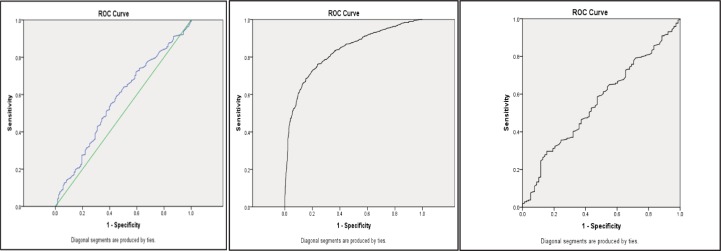
ROCs for CT values.ROCs for CT values against a) mortality (AUROC 0.569) and b) CTA (0.83) and c) recurrence (0.557).